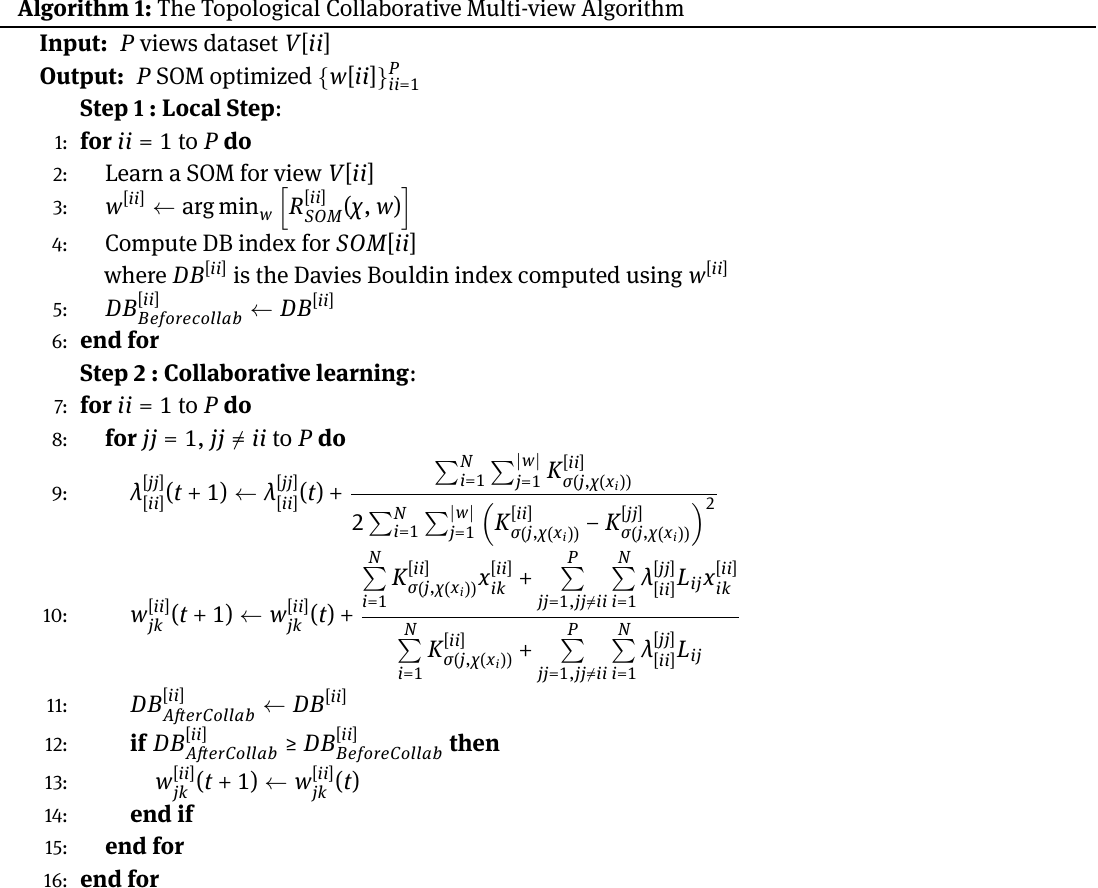
Algorithm 1: The Topological Collaborative Multi-view